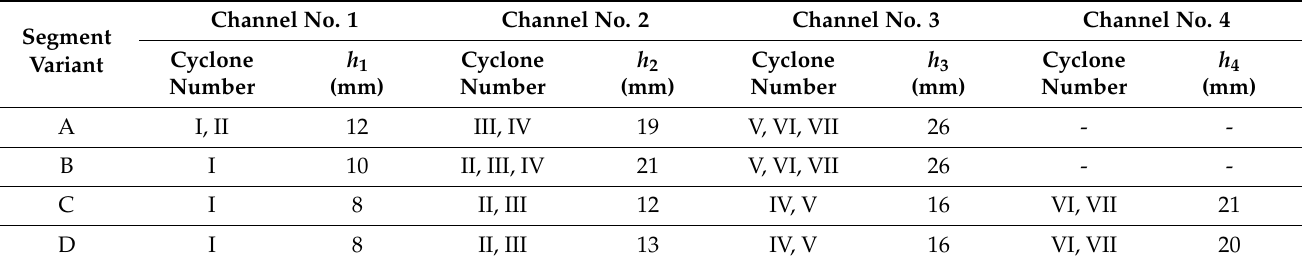
Table 3. Settling tank variants of S MT segment in MT